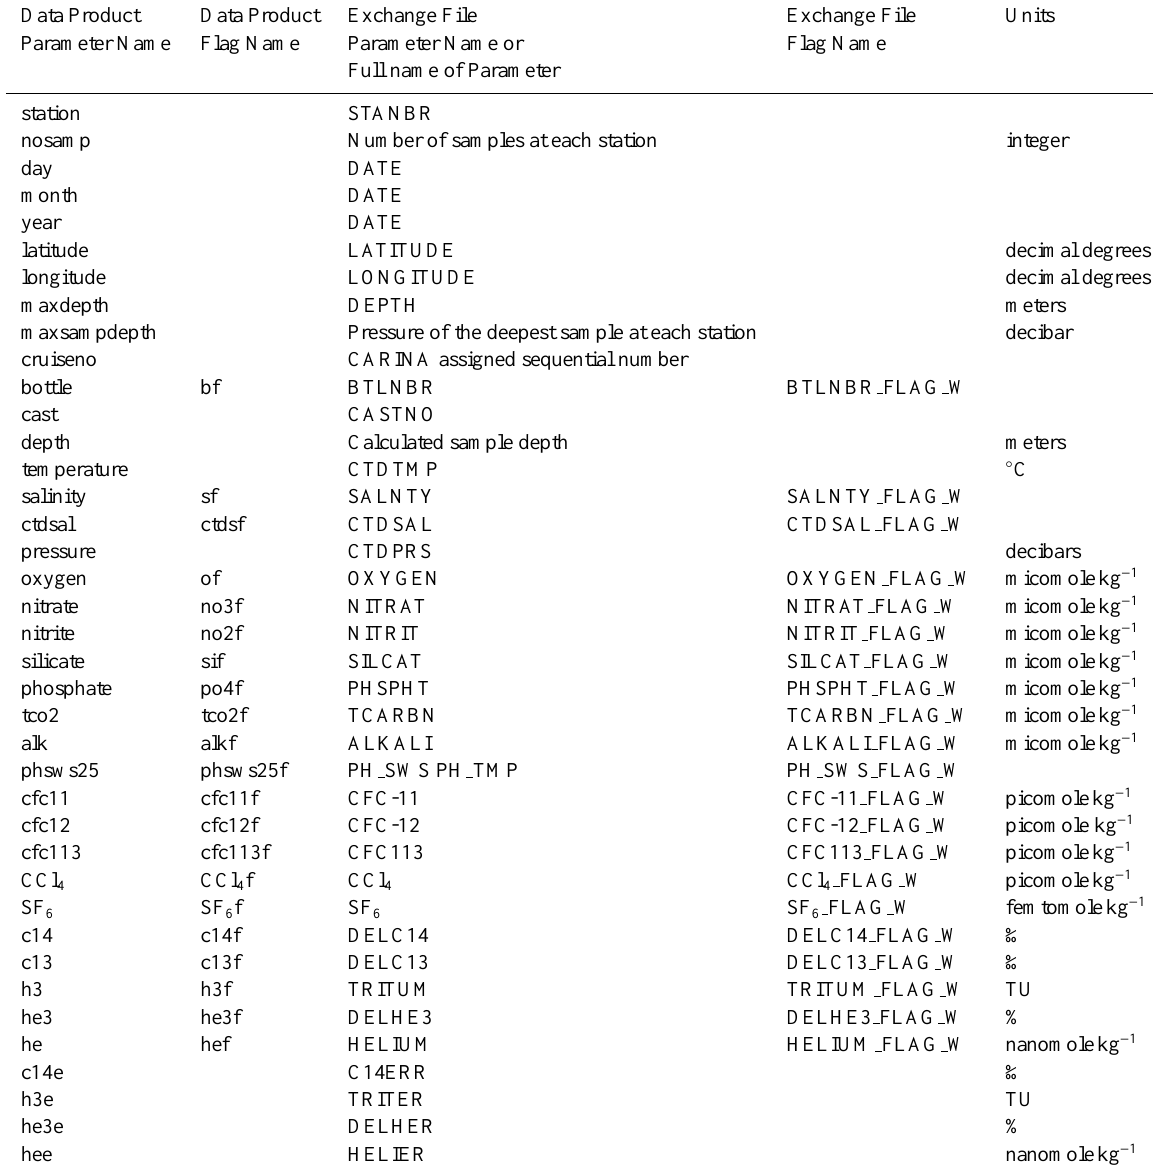
Table 2. Translation table for parameter names, flags and